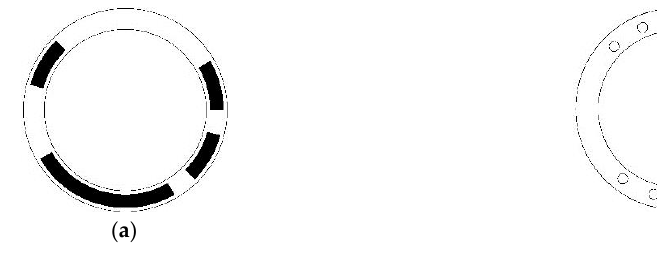
Figure 5. Disc pattern and reading head distribution of absolute encoder using a length-6 period-48 twin-necklace ordering STGC: ( a ) Schematic of the coding disc, where white area indicates “0”, and the black area indicates “1”; ( b ) Schematic of the reading disc, where the six small circles denote the six reading heads, and the sub-cycle of the head interval is two.